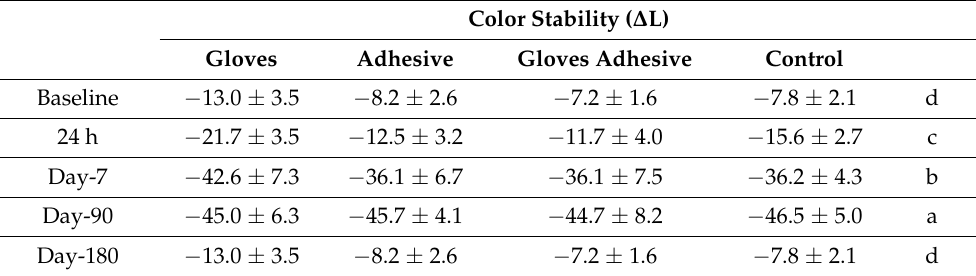
Table 5. Data resulting from color stability test ( ∆ L) for composite resin specimens handled/modeled under different techniques (gloved-hands and/or adhesive), in different evaluation times